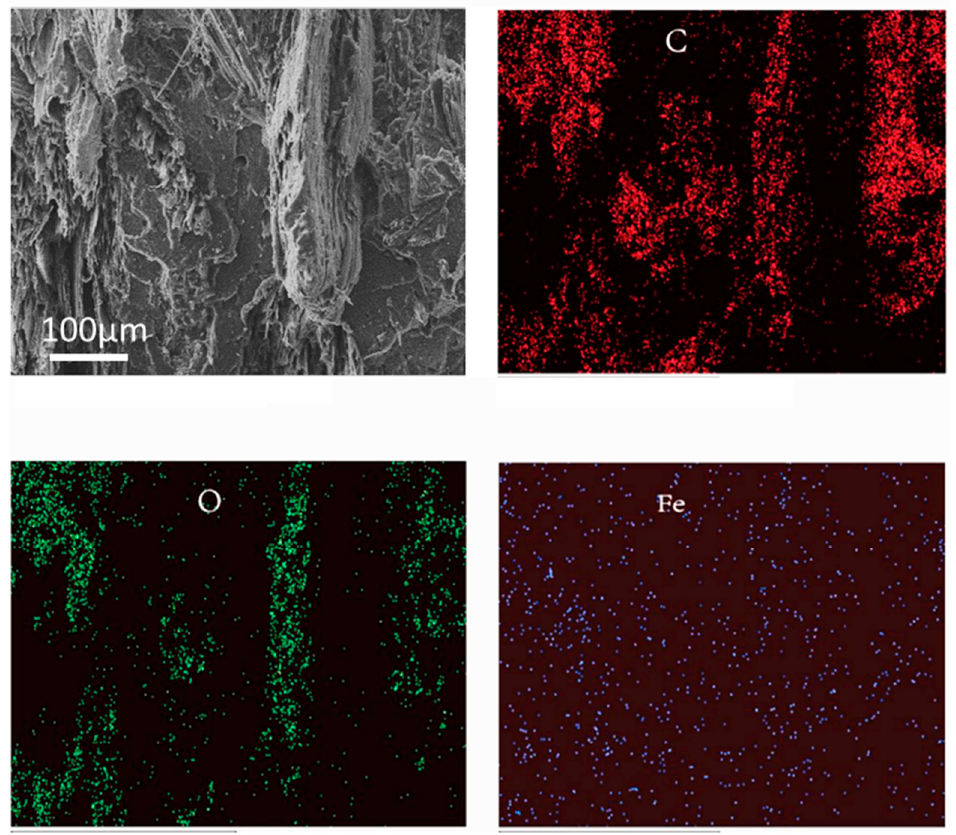
Figure 6. Energy dispersive spectroscopy (EDS) spectrum of the magnetic biocomposites (MWPC40).